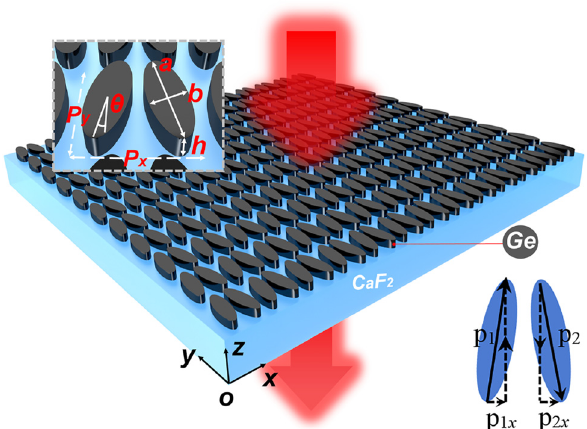
Figure 1: Schematic diagram of the structure supporting the QBIC resonance, with the inset presenting an enlargement of a single periodic cell. The inset in the lower right corner denotes the formation of the QBIC mode due to two counter-directional electric